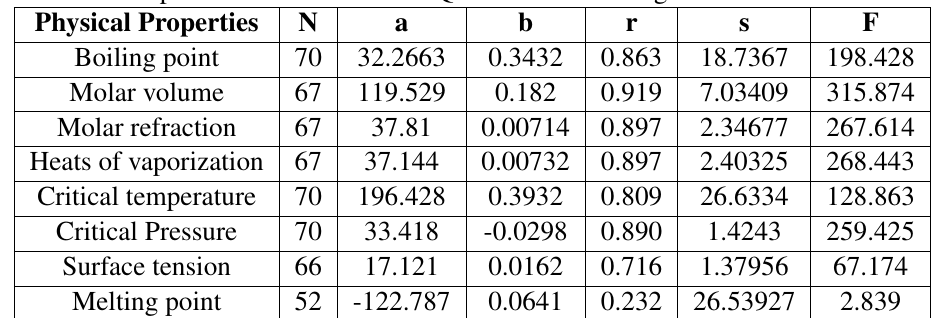
Table 6. Statical parameters for the linear QSPR model for Degree distance